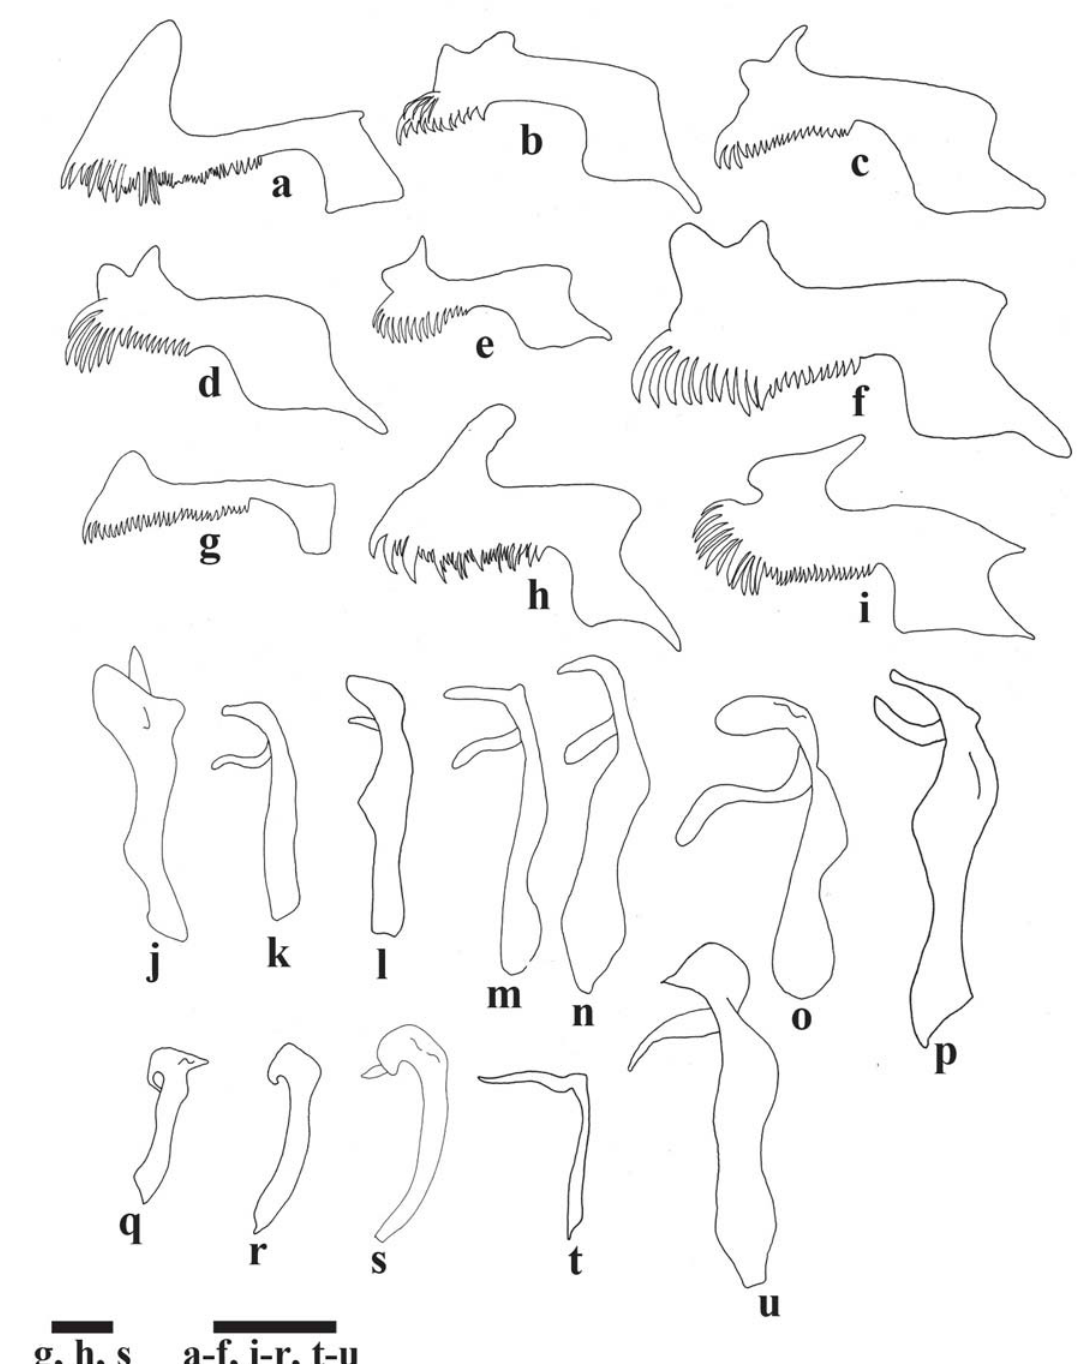
Fig. 4. Lateral view of premaxilla in: a ) Pseudoxiphophorus diremptus , LSUMZ 14337; b ) Xiphophorus mayae , LSUMZ 14336; c ) Carlhubbsia stuarti , USAC 204; d ) Phallichthys amates , CAS 587873; e ) Phallichthys fairweatheri , USAC 1797; f ) Xiphophorus alvarezi , USAC 1782; g ) Alfaro hubber , USAC 850; h ) Profundulus labialis , LSUMZ 14328; i ) P. guatemalensis , USAC 769; maxilla in: j ) Pseudoxiphophorus diremptus , LSUMZ 14337; k ) Poeciliopsis latidens , CAS 54436; l ) Brachyrhaphis olomina , TU 24997; m ) Xenophallus umbratilis , TU 186285; n ) Poecilia rositae , USAC 1822; o ) Poeciliopsis gracilis , TU 84966; p ) Alfaro cultratus , TU 24927; q ) Pamphorichthys araguaiensis , MCP 40919; r ) Heterandria formosa , TU 24002; s ) Limia melanogaster , MCZ 258314; t ) Fluviphylax pygmaeus , MCP 38830; u ) Profundulus guatemalensis , USAC 769. Scale bars = 1